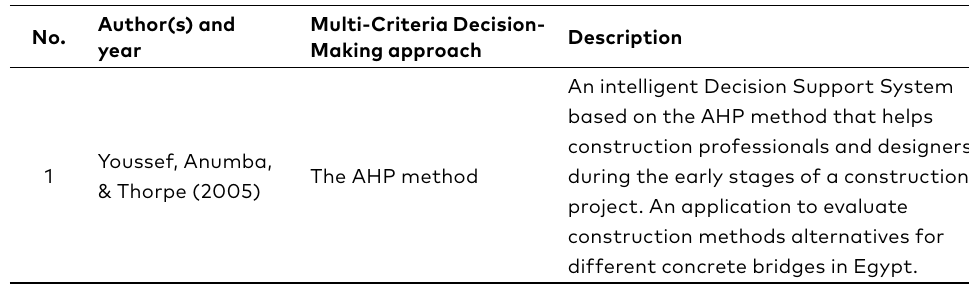
Table 1. Applications of the Multi-Criteria Decision-Making approaches in bridge